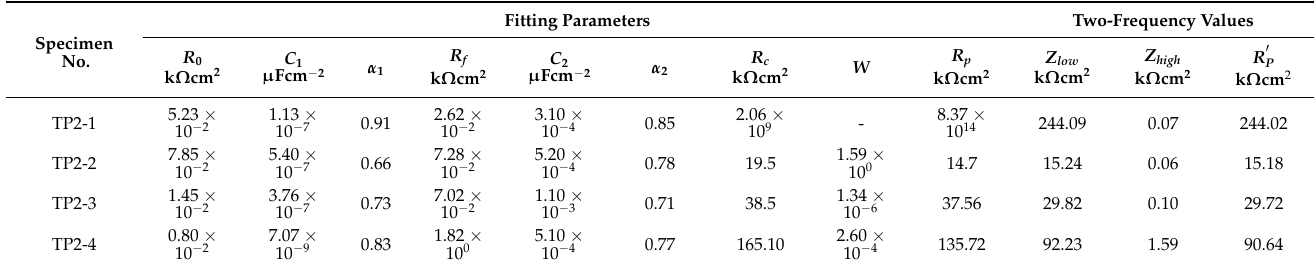
Bode plots obtained from EIS are informative on the variation of interfacial condi- tions of steel and concrete in the concrete samples during EDT. The phase shift curves in Figure 9b shows that there are valleys in a low frequency region (100 Hz to 0.001 Hz). There are the other valleys appearing in the high frequency regions (100 kHz~10